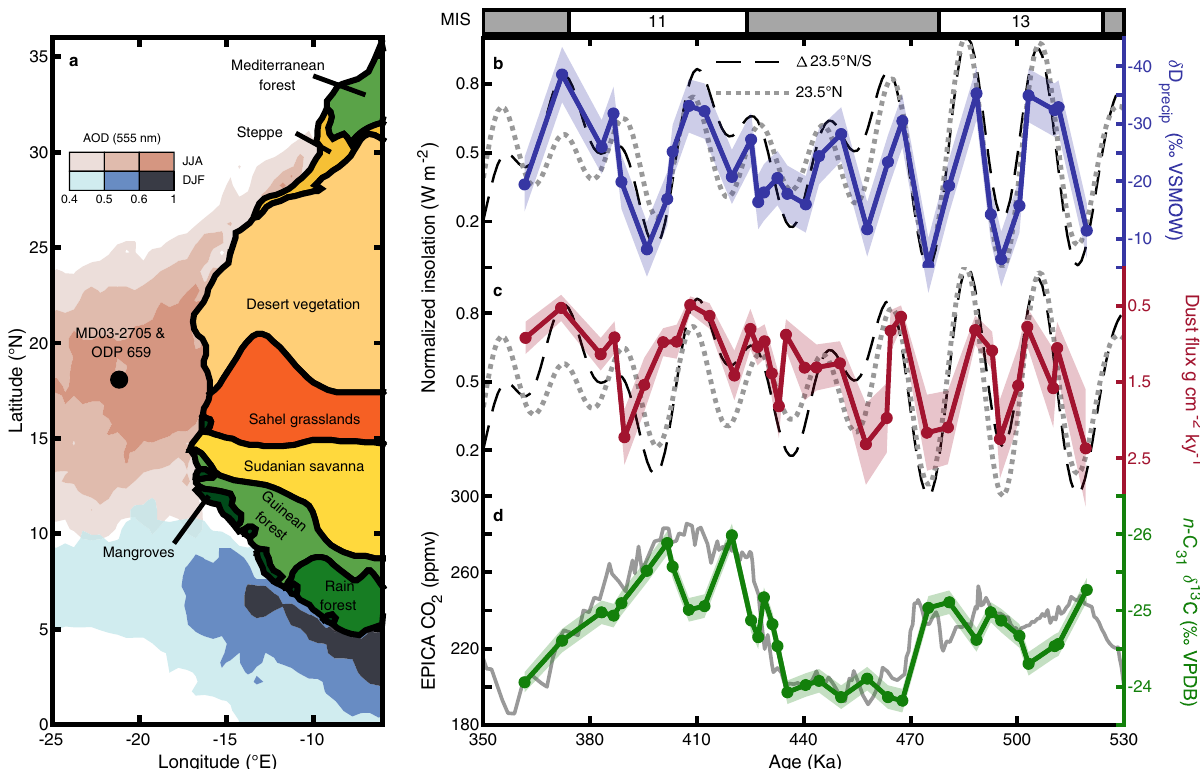
Fig. 1 Regional context and new records of monsoon rainfall, dust, and vegetation. a Map of Northwest Africa with biome distributions on land ref. 54 , the aerosol optical depth (AOD, 555 nm) (summer: JJA and winter: DJF, 2000 – 2017) over the ocean (Giovanni, NASA EarthData) showing the location of the modern summer and winter Saharan dust plumes (colorbar, ref. 127 ), the core location for MD03-2705 and ODP 659 is labeled with a black circle b δ D precip with 1 σ uncertainty plotted with June 21 23.5°N insolation (dotted line, r = − 0.77) and the summer inter-hemispheric insolation gradient June 21 23.5°N – 23.5°S (dashed line, r = − 0.76), insolation was determined using ref. 126 and normalized to values between 0 and 1. c 3 He ET -normalized dust fl ux plotted with insolation curves as in a (23.5°N, r = − 0.46; Δ 23.5°N/S, r = − 0.50). d Plant-wax C 31 n -alkane δ 13 C with 1 σ uncertainty plotted with EPICA ice core CO 2 concentration ref. 128 ( r = – 0.81). δ D precip and 3 He ET -normalized dust fl ux are also well correlated ( r = 0.68). All correlation coef fi cients are signi fi cant at a p value of <0.01. Marine isotope stages (MIS) are indicated with interglacials periods shown in white and glacial periods in